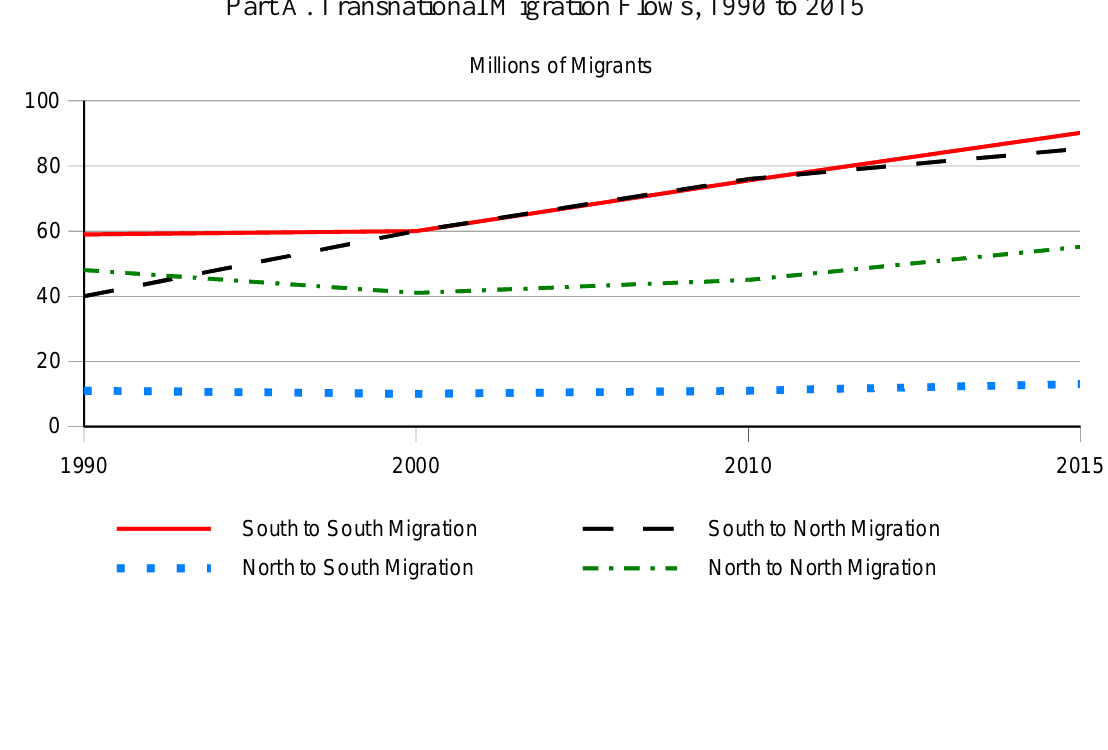
Part B . The Nonwestern Destinations of Transnational Migrants,